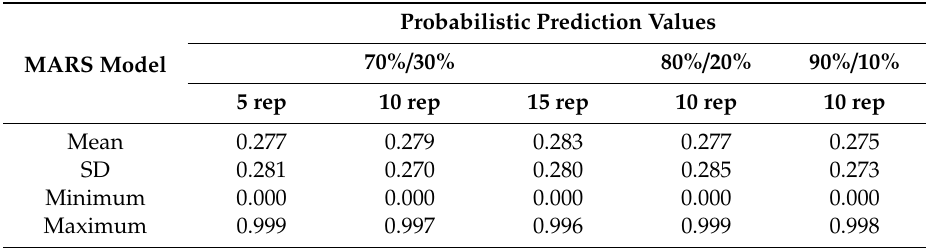
Table 4. Actuarial features of the probability values inferred from the MARS model.